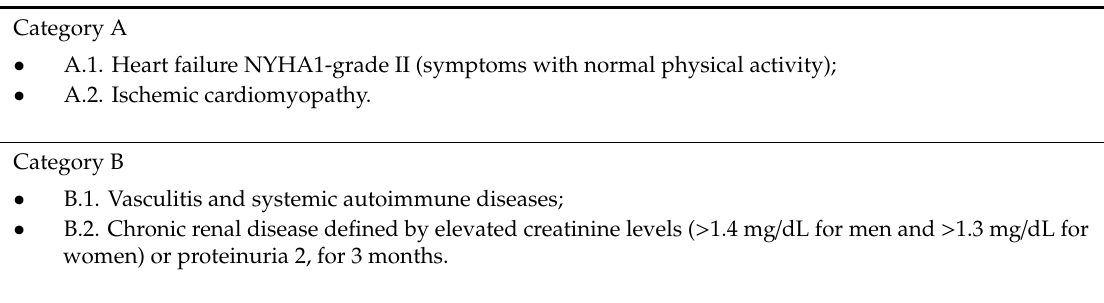
Table 1. Categories of patients with multiple